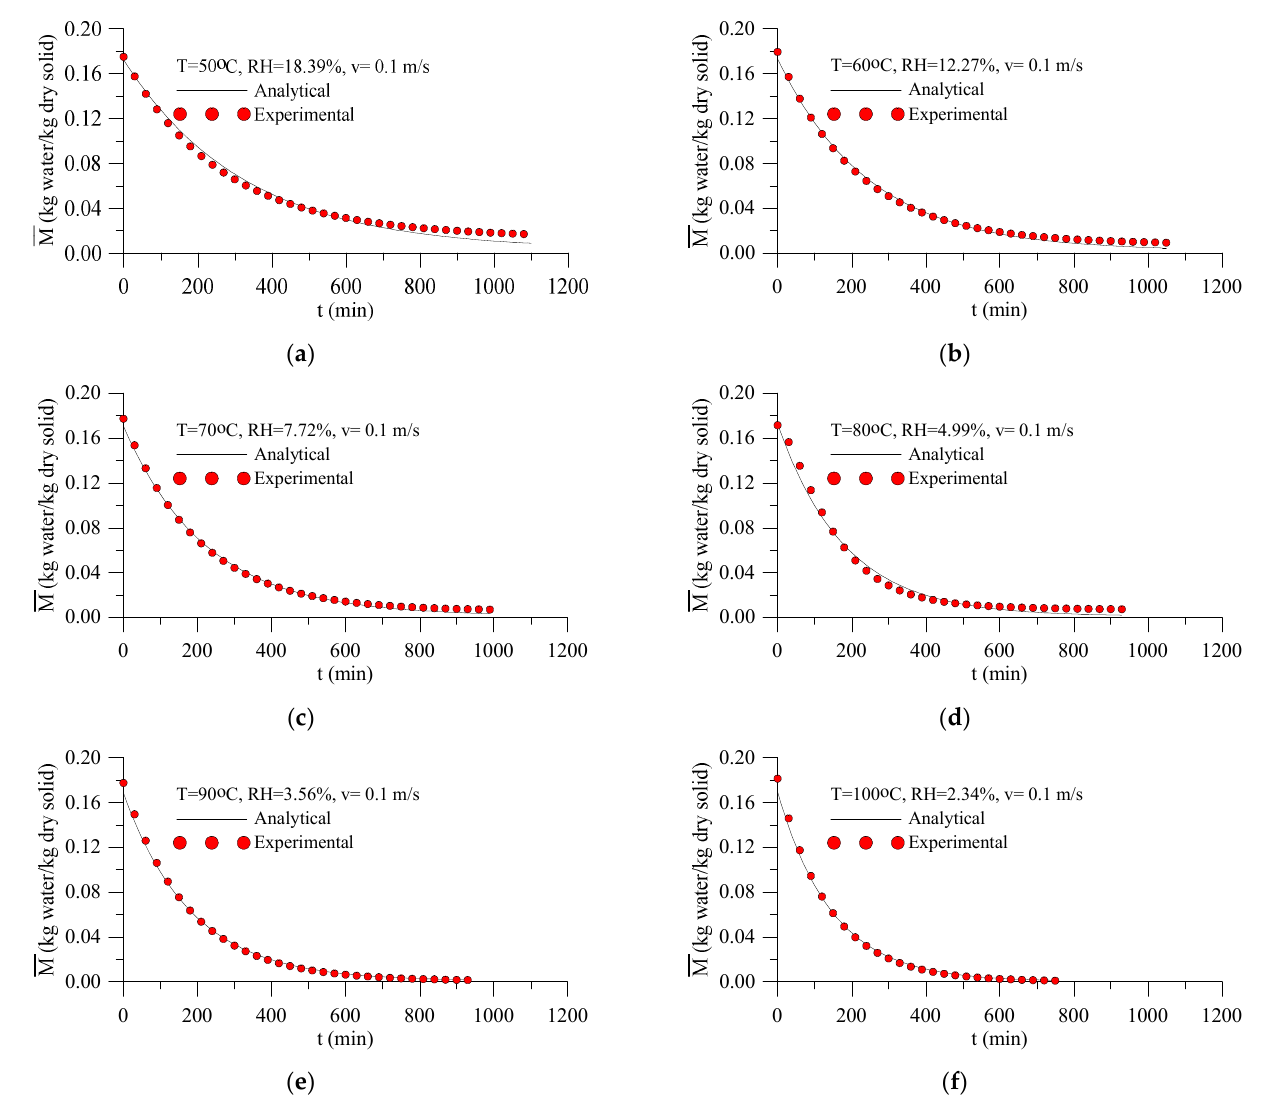
Figure 2. Transient behavior of predicted and experimental [14] moisture content of the ceramic block for different drying temperatures: ( a ) T = 50 °C, ( b ) T = 60 °C, ( c ) T = 70 °C, ( d ) T = 80 °C, ( e ) T = 90 °C, and ( f ) T = 100 °C.